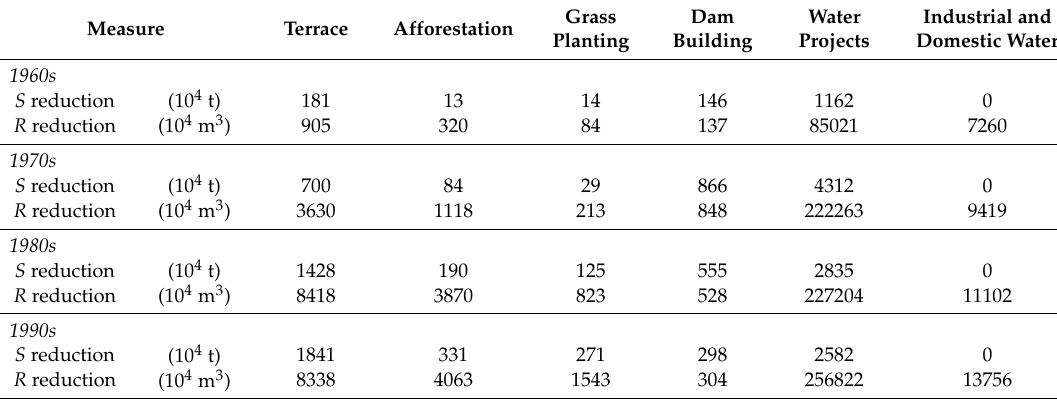
Table 3. Runoff and sediment reduction from primary anthropogenic activities at Huaxian station from 1960s to 1990s.